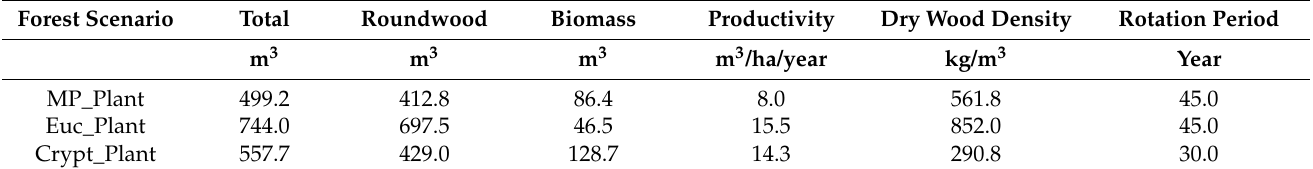
Table 1. Total volume of roundwood produced per hectare of land, volume of co-products produced per hectare of land, stands’ productivity, dry wood density and rotation period of various